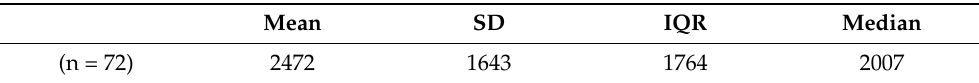
Table 2. Mean SP plasma concentrations in pg/mL at t0 of all horses used in this study (experimental group (n = 16), control group (n = 10), reference group (n =